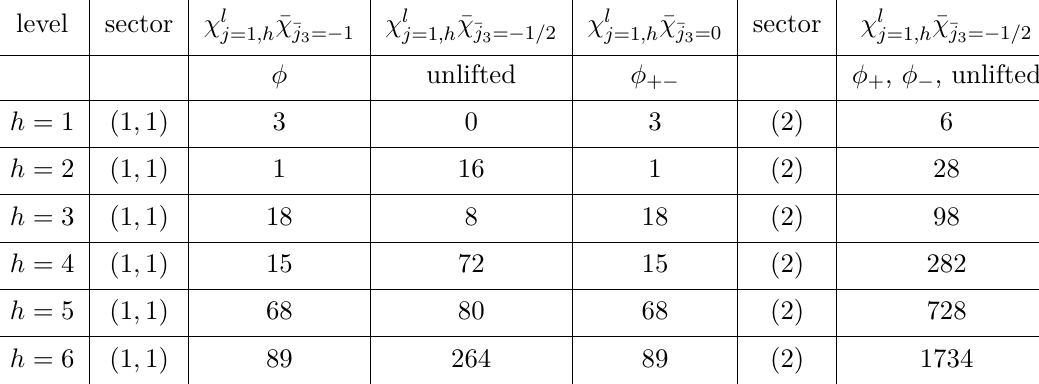
Table 1 . The character decomposition at the orbifold